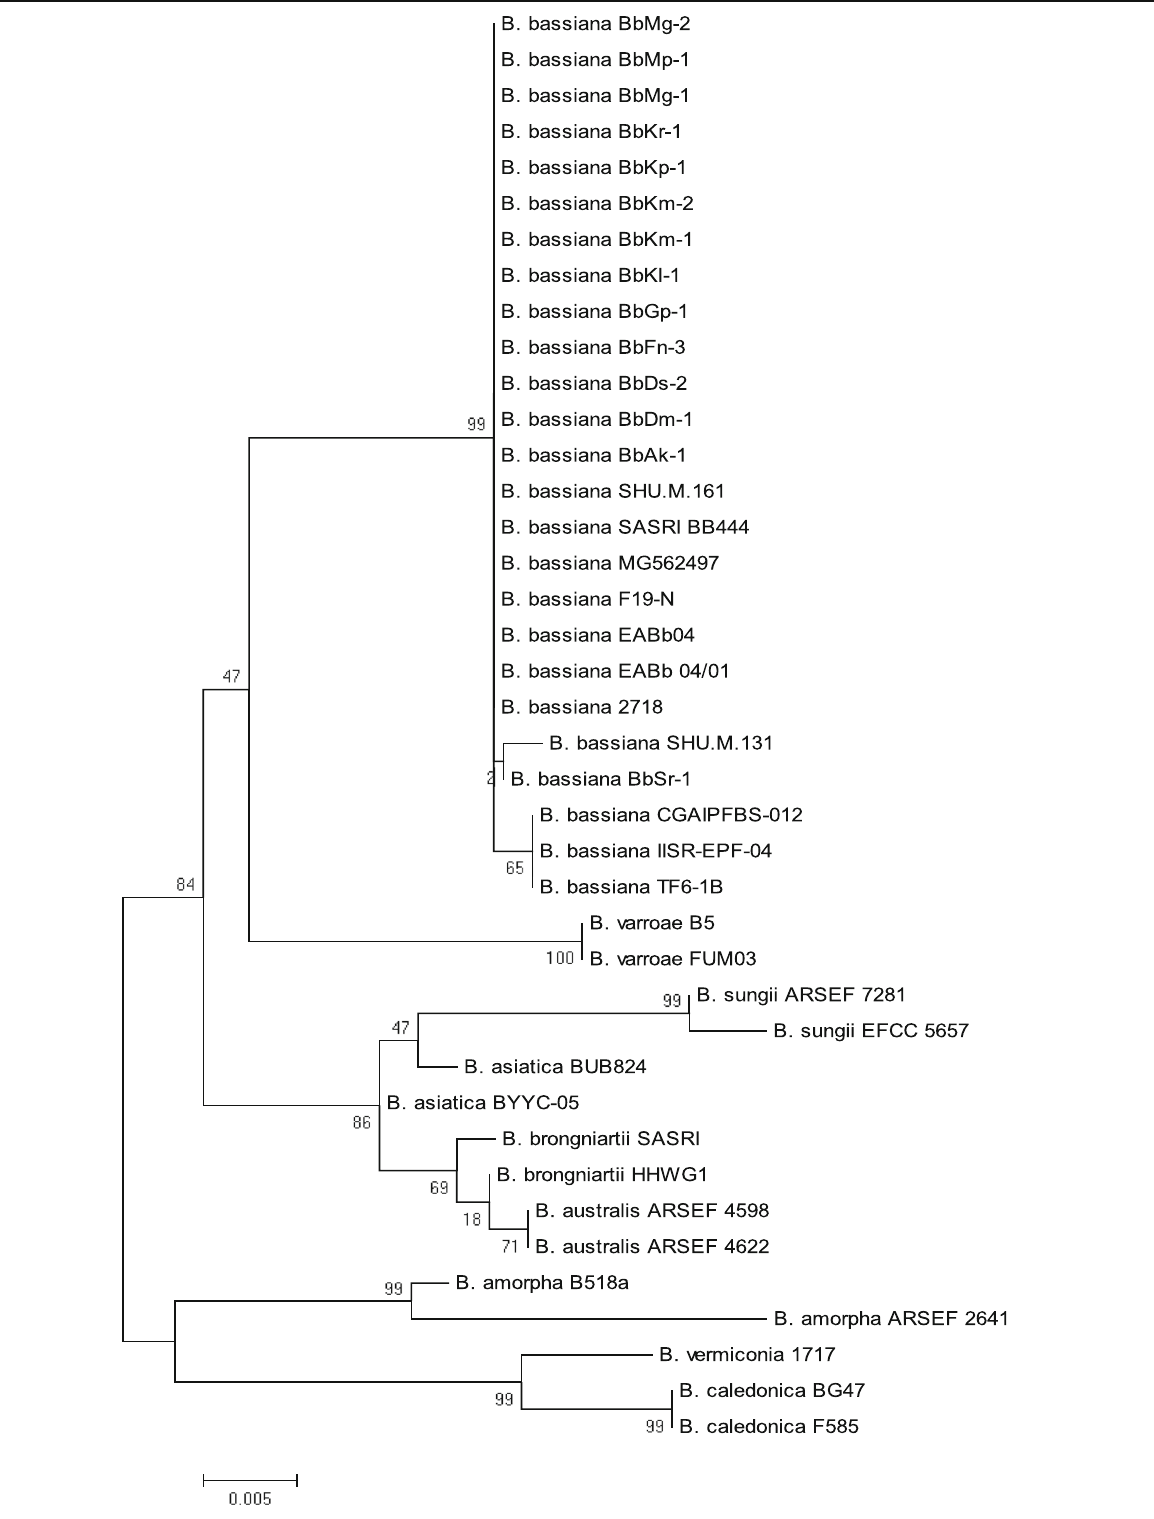
Fig. 1 Maximum likelihood tree based on the Tamura 3-parameter model showing the phylogenetic relationship between the tested Beauveria bassiana isolates and other Beauveria isolates from GenBank based on ITS region